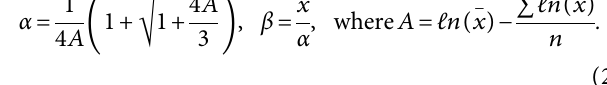
Figure 3 describes the methodology used in this study.